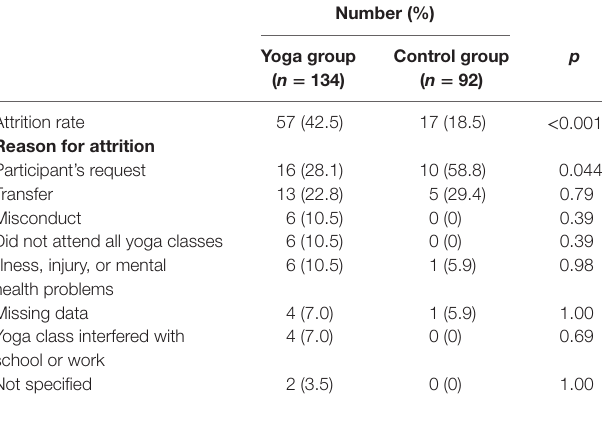
TaBle 1 | Attrition rates and reasons for attrition in the yoga and control groups.